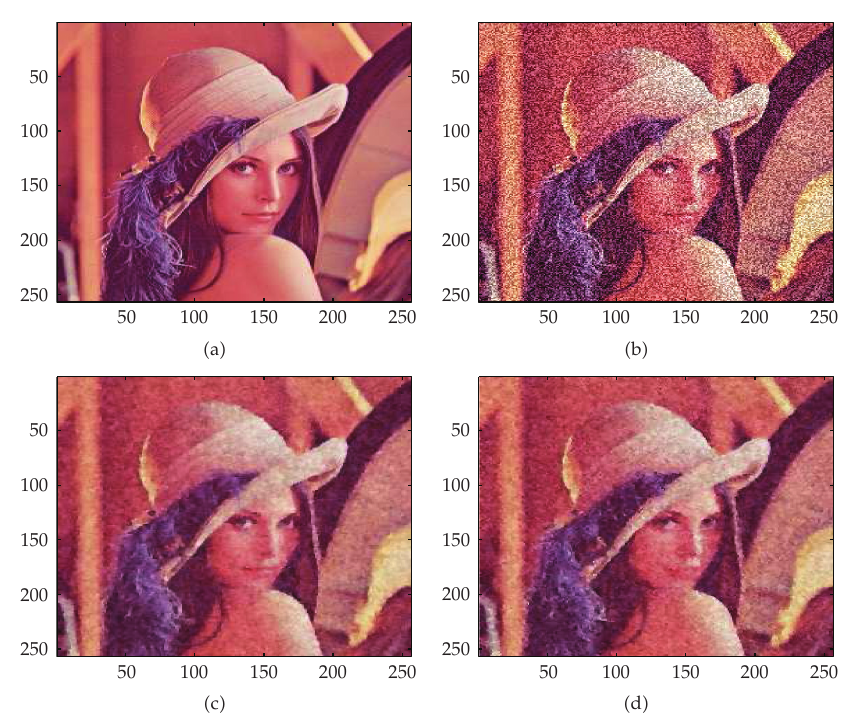
Figure 3: (cid:7) a (cid:8) original image, (cid:7) b (cid:8) noisy image (cid:7) SNR (cid:10) 10 . 59 (cid:8) , (cid:7) c (cid:8) restored image by the classical topological gradient method (cid:7) SNR (cid:10) 19 . 44, CPU (cid:10) 61 . 03 (cid:8) , and (cid:7) d (cid:8) restored image using Ambrosio-Tortorellialgorithm